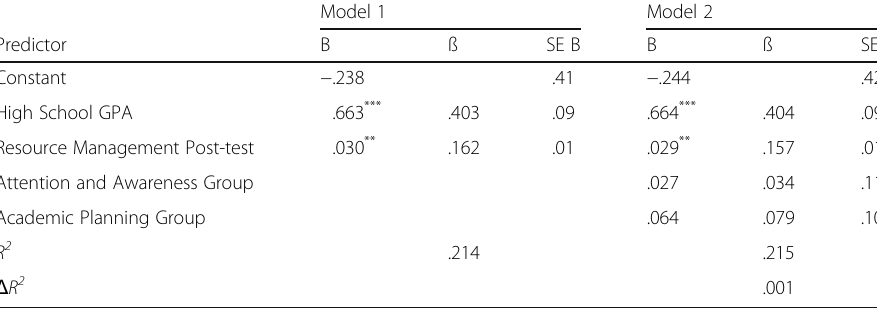
Table 4 Sequential regression of first semester